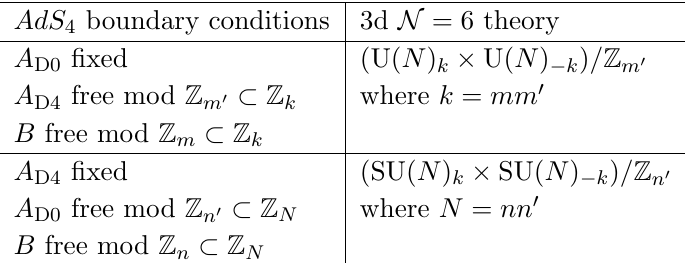
Table 2 . Generalized AdS